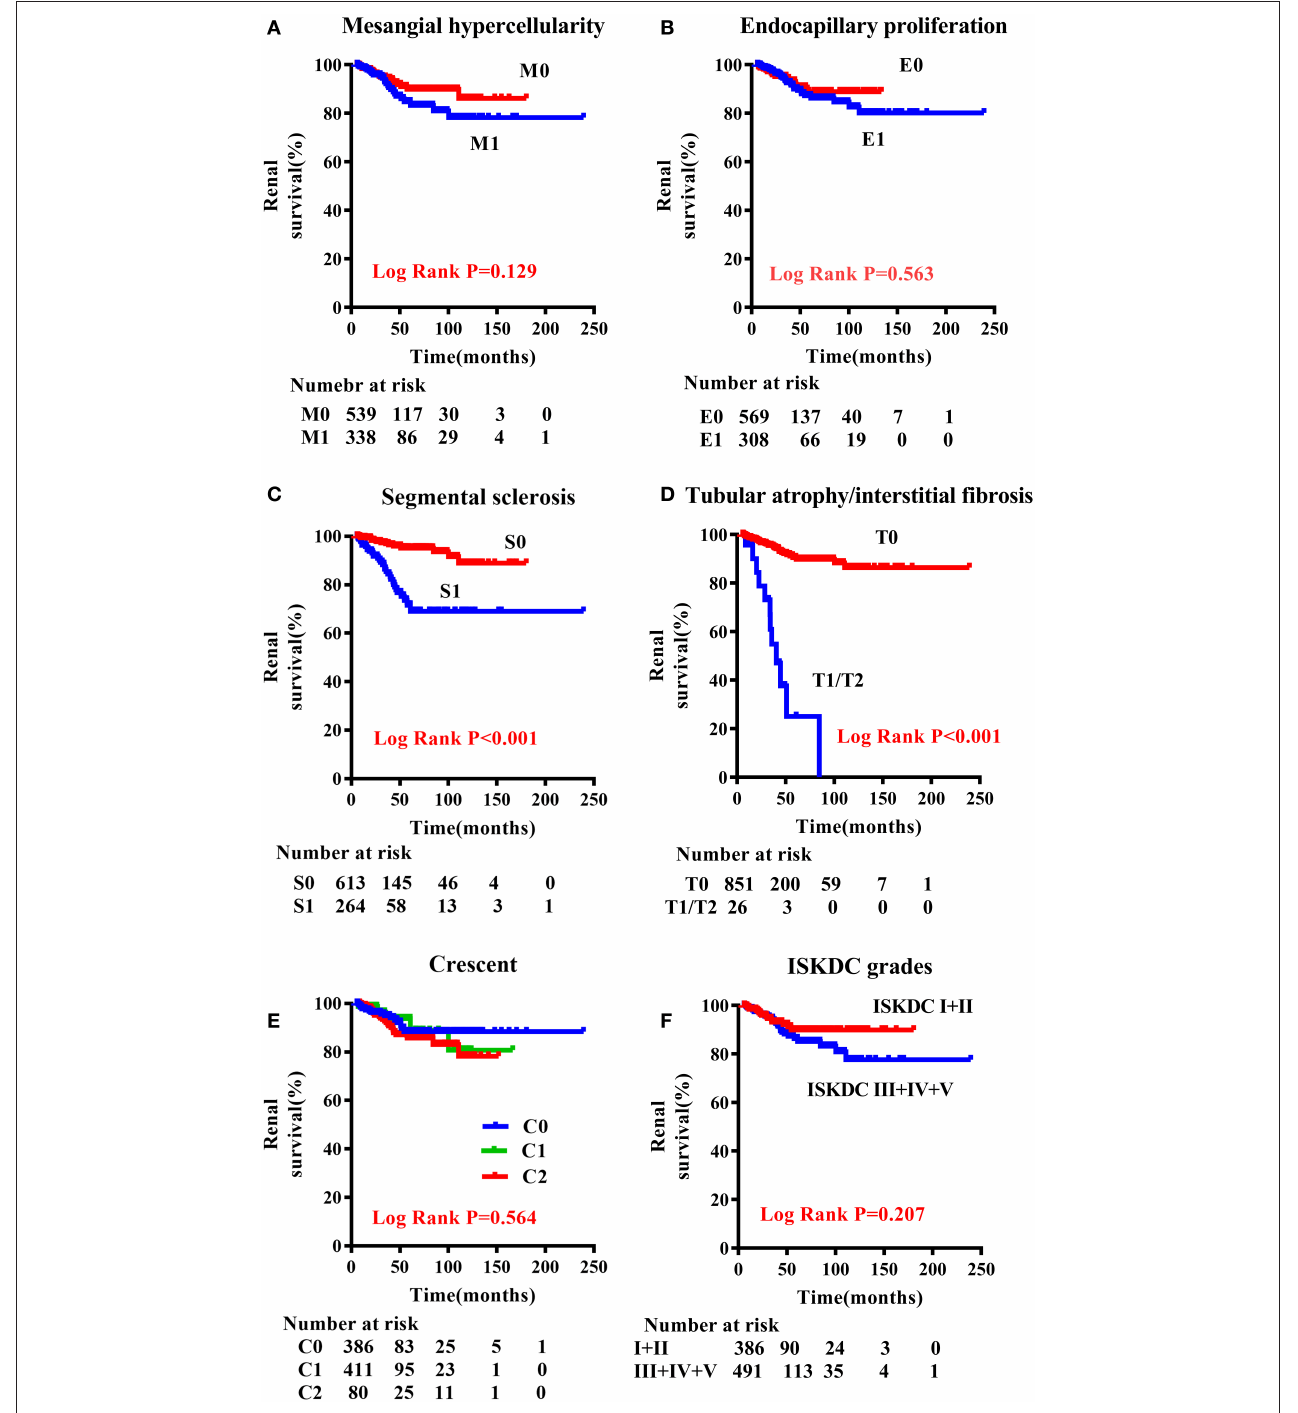
FIGURE 1 | Renal outcome-free survival curves according to the Oxford classification and ISKDC classification in children with HSPN. (A) M0 vs. M1; (B) E0 vs. E1; (C) S0 vs. S1; (D) T0 vs. T1/T2; (E) C0 vs. C1 vs. C2; (F) ISKDC I + II vs. ISDKC III + IV + V. M, mesangial hypercellularity; E, endocapillary proliferation; S, segmental sclerosis/adhesion; T, tubular atrophy/interstitial fibrosis; C, cellular or fibrocellular crescents.